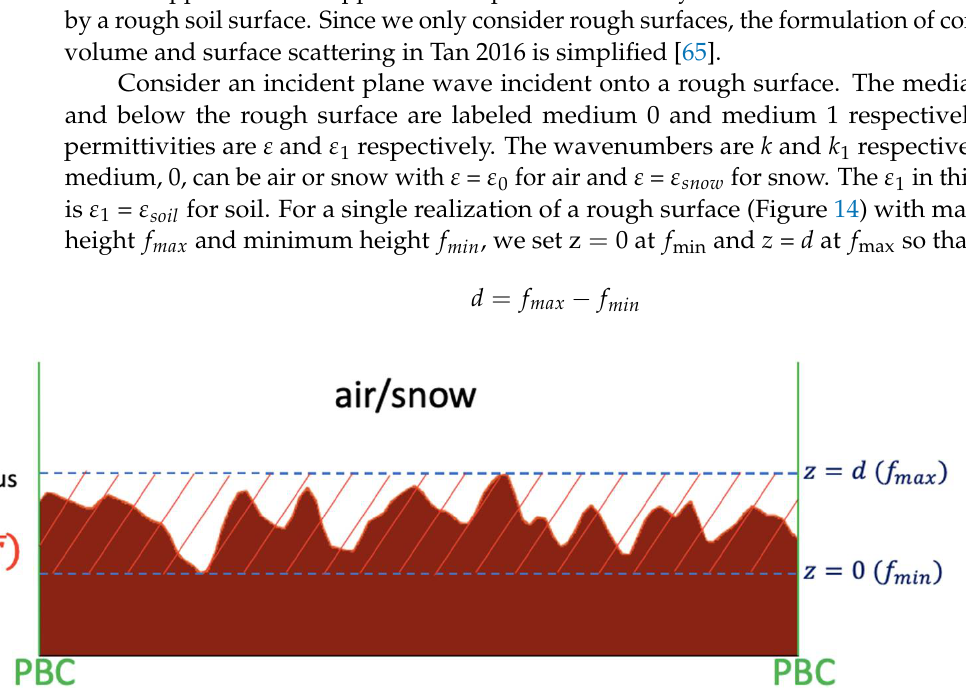
Figure 14. The illustration of simulation geometry, reference plane, periodic boundary conditions (PBC), and half space boundary.